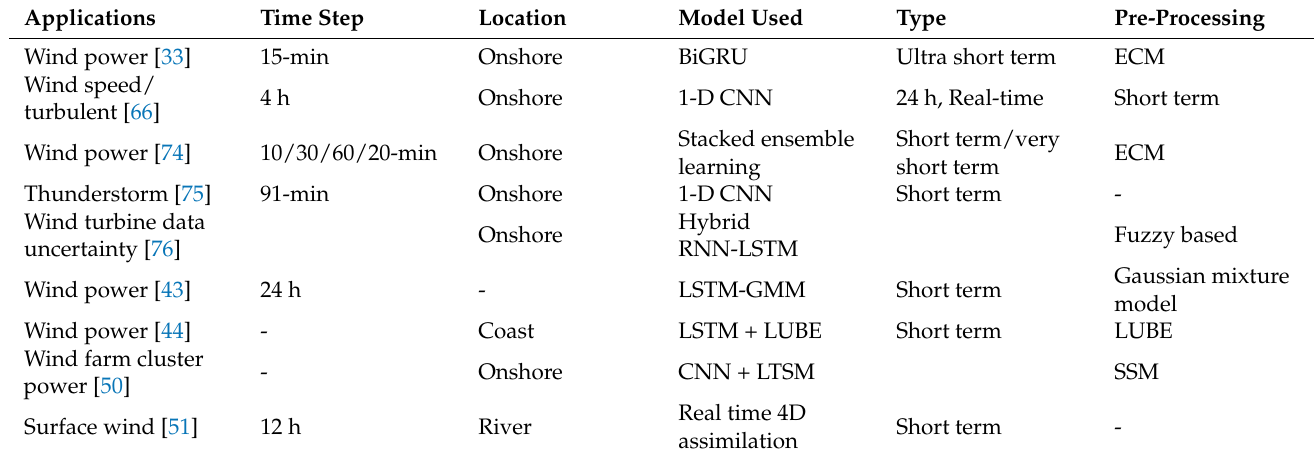
Table 4. Summary of deep learning models in other wind energy forecasting